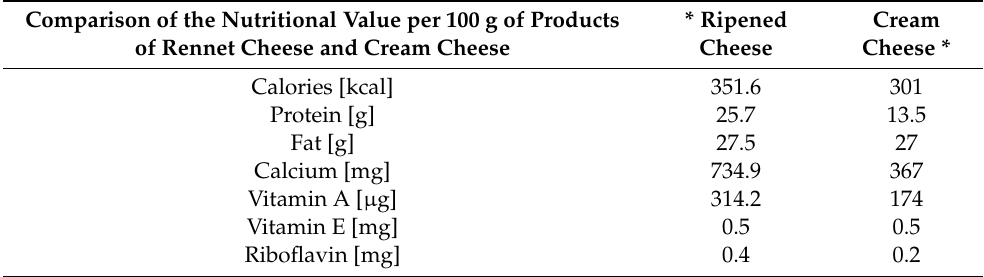
Table 6. Comparison of the nutritional value of rennet cheese and cream cheese. Comparison of the Nutritional Value per 100 g of Products